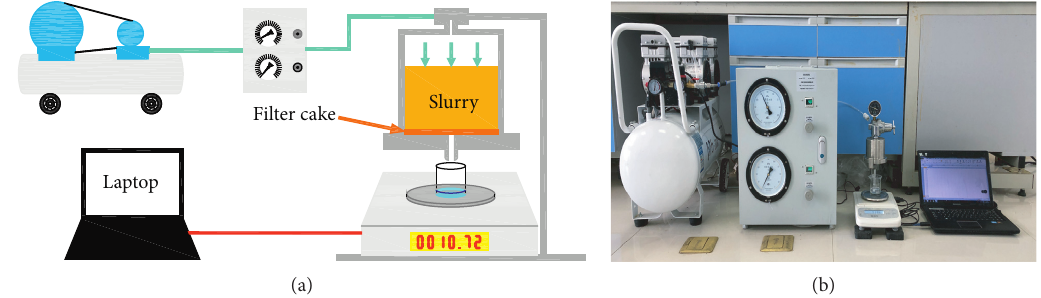
Figure 3: Permeability measurement system: (a) schematic diagram; (b) experimental setup.